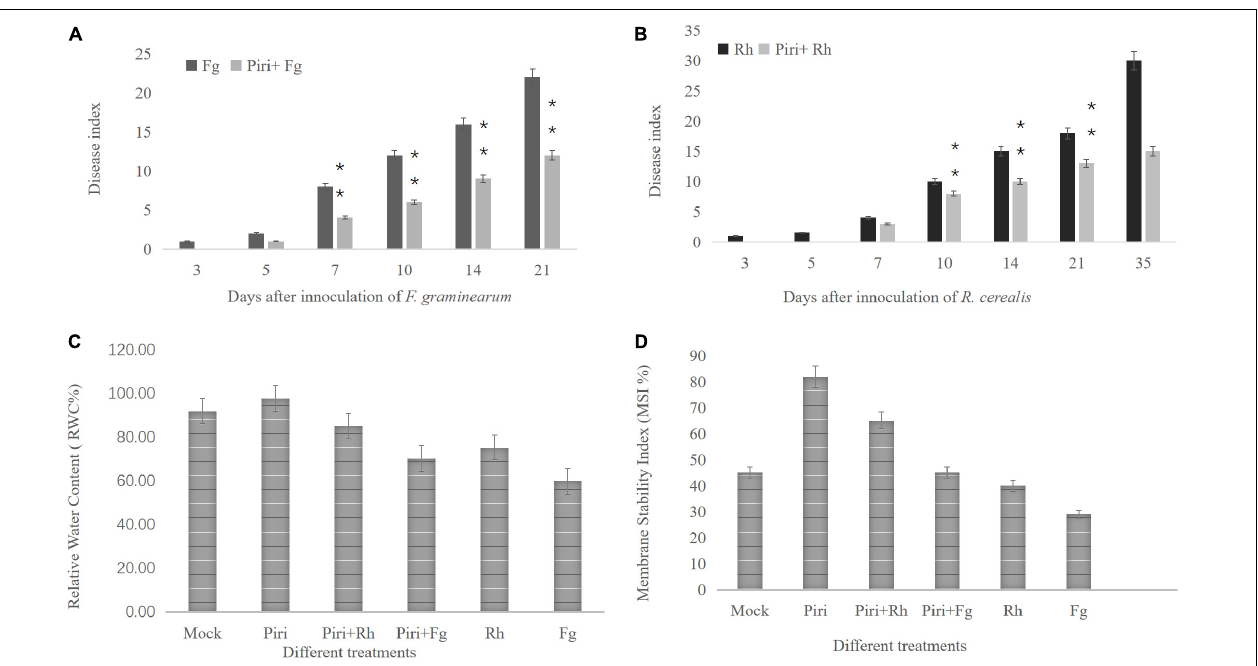
FIGURE 3 | Disease index evaluation and relative water content (RWC) and membrane stability index (MSI) determination. (A) The wheat seedlings were infected by F. graminearum at 14 days post inoculation (dpi) with P. indica and harvested at different time-points, including 3, 5, 7, 10, 14, and 21 days. Effect of different treatments, including Fg, Piri + Fg on progress of the disease on the wheat seedlings were evaluated. (B) The wheat seedlings were infected by R. cerealis at 14 days post inoculation (dpi) with P. indica and harvested at different time-points, including 3, 5, 7, 10, 14, 21, and 35 days. Effect of different treatments, including Rh and Piri + Rh on progress of the disease on the wheat seedlings were evaluated. (C) Effect of various treatments of Mock, Piri, Fg, Piri + Fg, Rh, and Piri + Rh on relative water content (RWC). (D) Effect of various treatments of Mock, Piri, Fg, Piri + Fg, Rh, and Piri + Rh on membrane stability index (MSI). Piri, P. indica ; Fg, F. graminearum ; Rh, R. cerealis ; Piri + Fg, P. indica + F. graminearum ; Piri + Rh, P. indica + R.